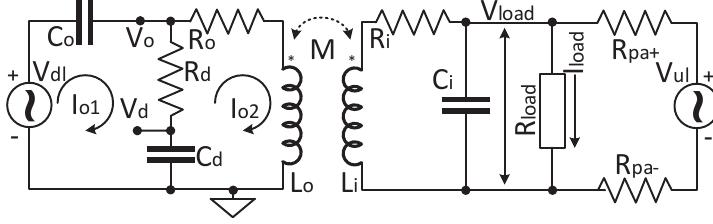
Figure 3. Circuit topology of the proposed inductive wireless